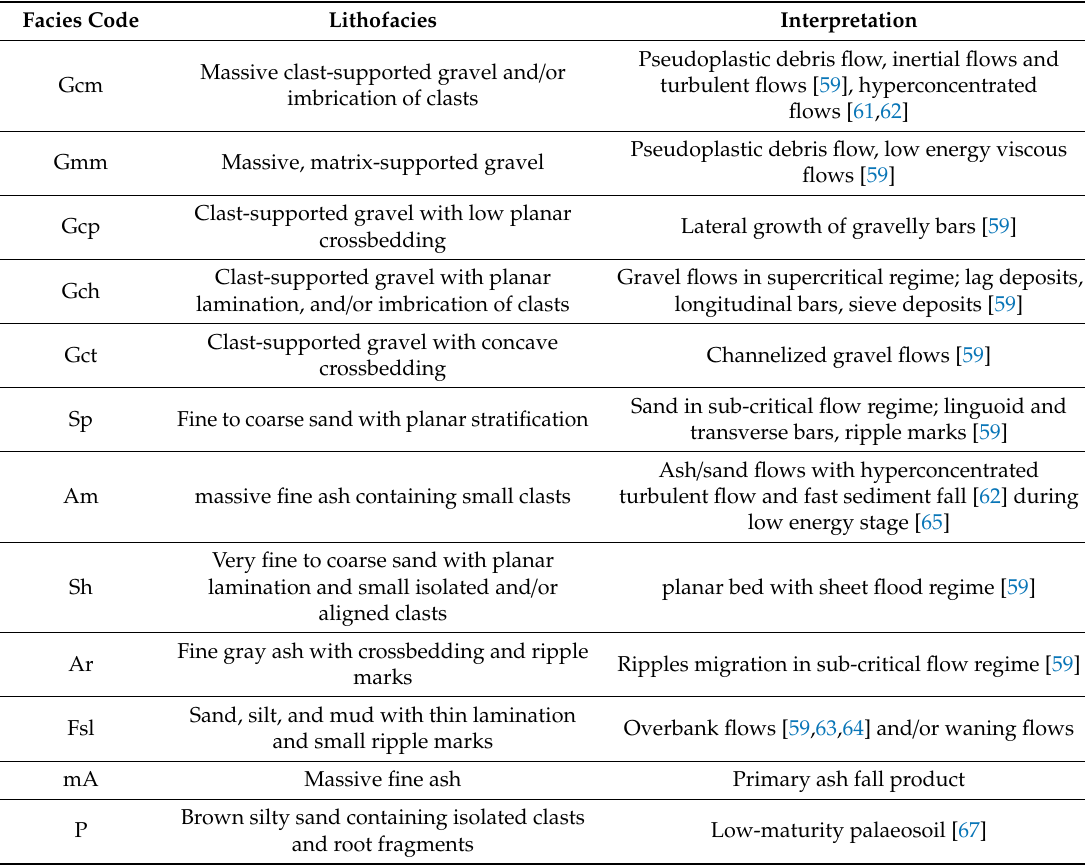
Table 1. Facies code, lithofacies, and relative interpretation of the fluvial terraced